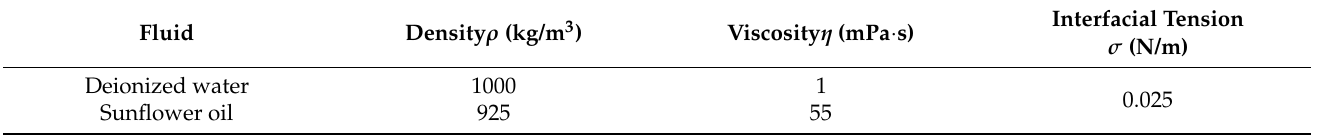
Table 1. Properties of the fluid samples.